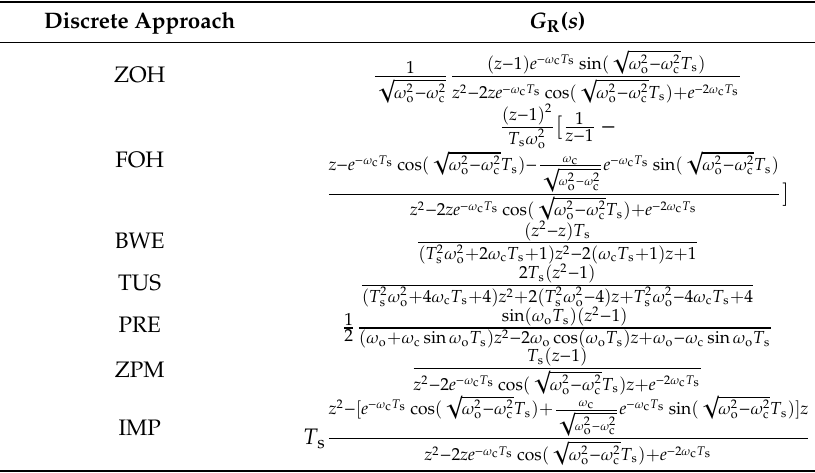
Table 2. Classification of discrete method.